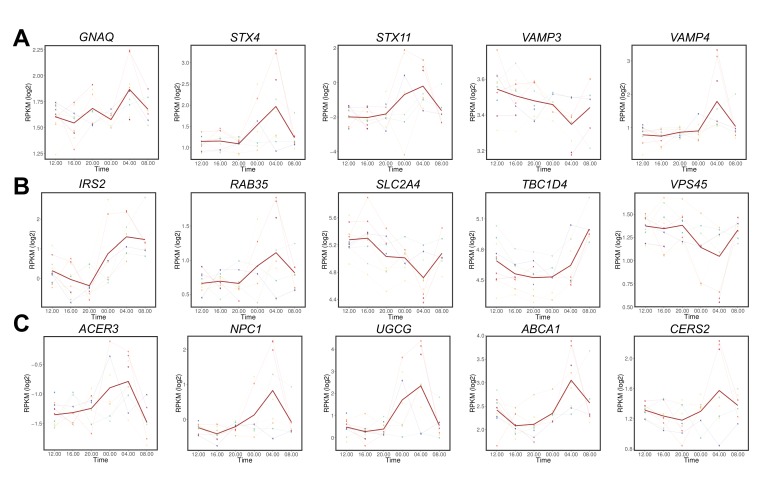
Temporal gene expression in human skeletal muscle.(A) Temporal expression of genes involved in vesicular trafficking; (B) Temporal expression of genes involved in glucose uptake; (C) Temporal expression of genes involved in lipid metabolism analyzed by RNA-seq. N = 10 human muscle biopsy donors.